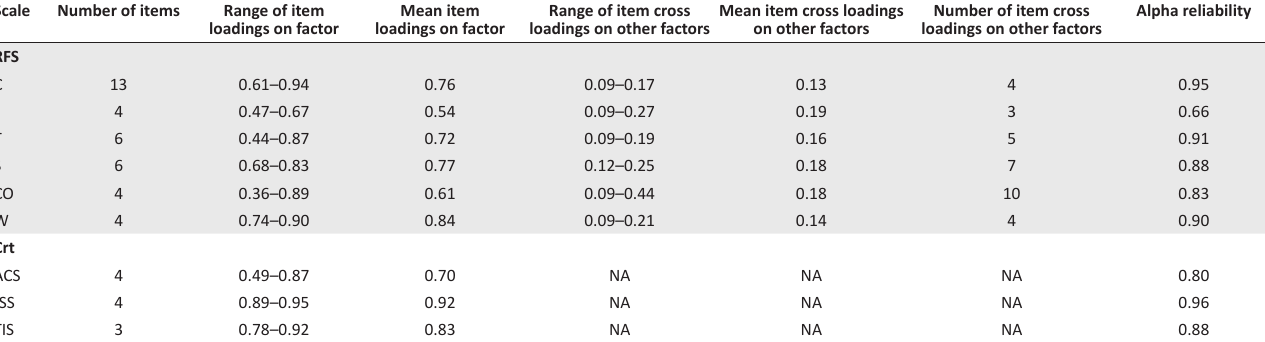
TABLE 3: The item loadings on the Retention Factor Scale factors for the restricted exploratory structural equation modelling within the confirmatory factor analysis model and the item loadings on factors for the attitudinal antecedents of the voluntary turnover model (criterion). Scale Number of items Range of item Mean item Range of item cross Mean item cross loadings loadings on factor loadings on factor loadings on other factors on other